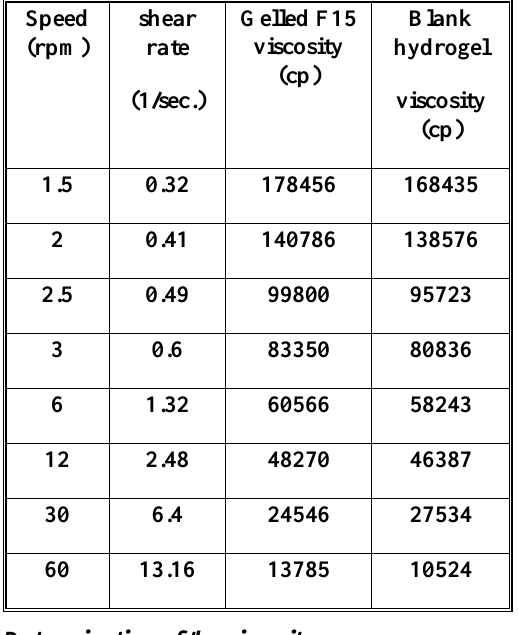
Table 8.Viscosity values for the prepared AC hydrogels